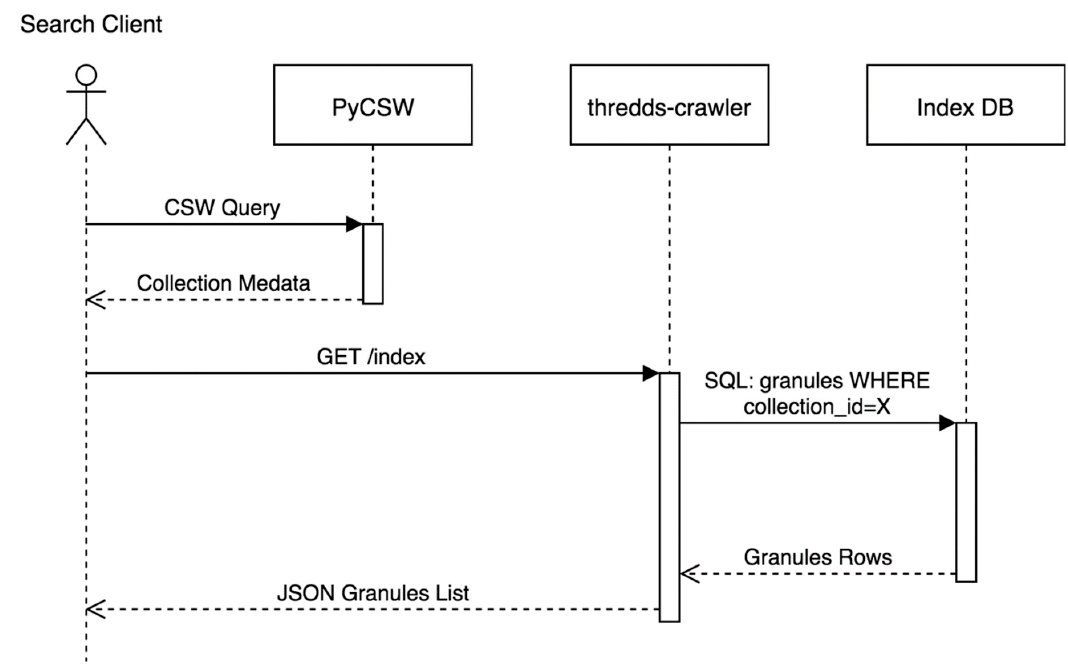
Figure 9. Simple granule index retrieval during search.